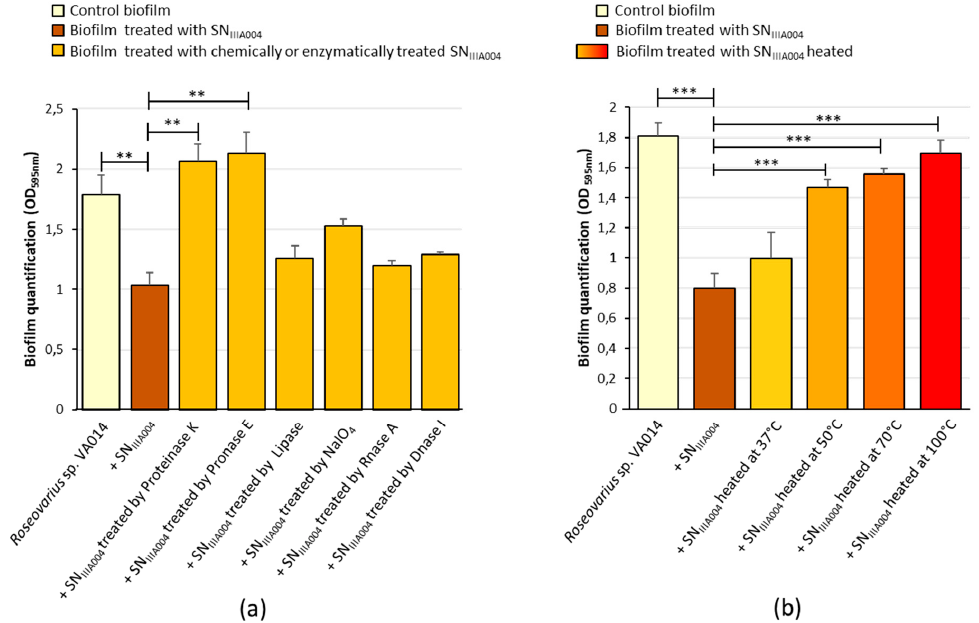
Figure 5. Effect of various treatments on the anti-biofilm activity of SN IIIA004 . Microtiter plate assay was used. ( a ) Effect of the digestion of proteins (proteinase K, pronase E), lipids (lipase), polysaccharides (NaIO 4 ), and nucleic acids (RNaseA, DNaseI) on the anti-biofilm activity of SN IIIA004 . ( b ) Effect of increasing heat treatments on the anti-biofilm activity of SN IIIA004 . Control biofilm: Roseovarius sp. VA014 biofilm treated with Zobell broth instead of SN IIIA004 . The data represent mean values ± standard deviations of at least three replicates. The effect of each SN IIIA004 submitted to a chemical or thermal treatment was compared with the effect of the native SN IIIA004 . Significant differences are indicated by ** ( p < 0.01) or *** ( p < 0.001).